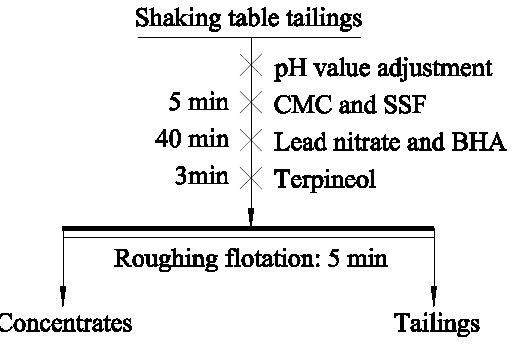
Figure 3. Rough flotation flowchart of the shaking table tailings (BHA—Benzohydroxamic acid; CMC—carboxymethyl cellulose; SSF—sodium fluorosilicate).